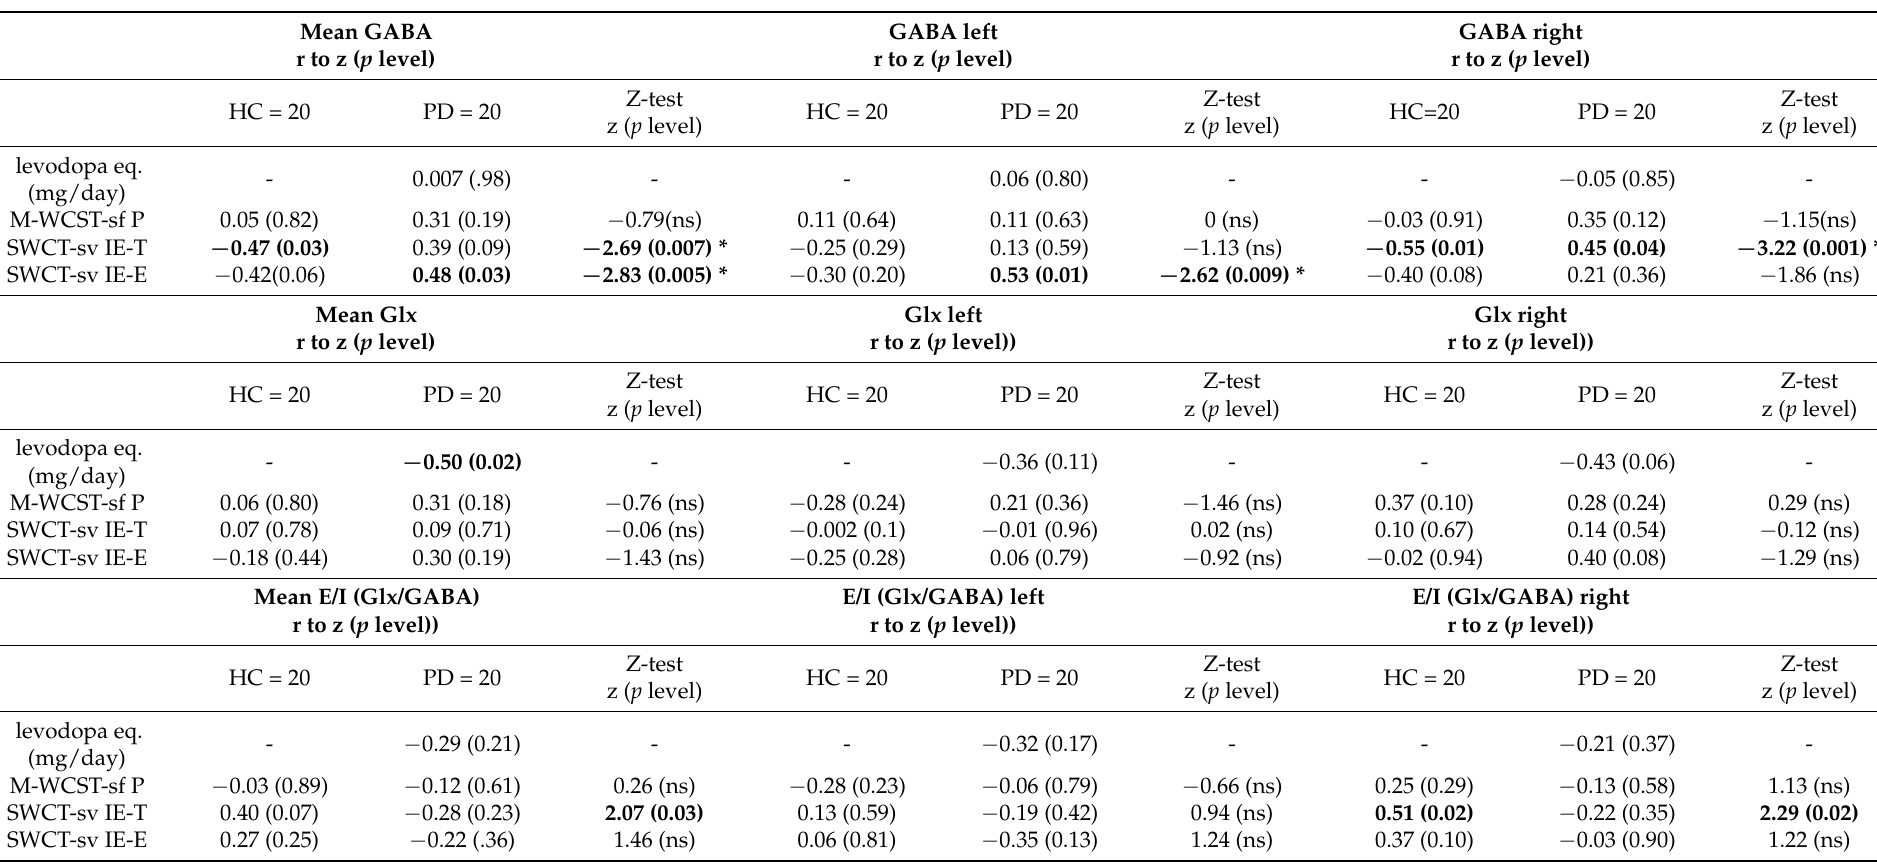
Table 3. Correlations between cerebellar GABA, Glx levels, excitation/inhibition balance and dopamine replacement therapy (daily levodopa equivalents), response inhibition measures in the studied samples and results from the test of difference between